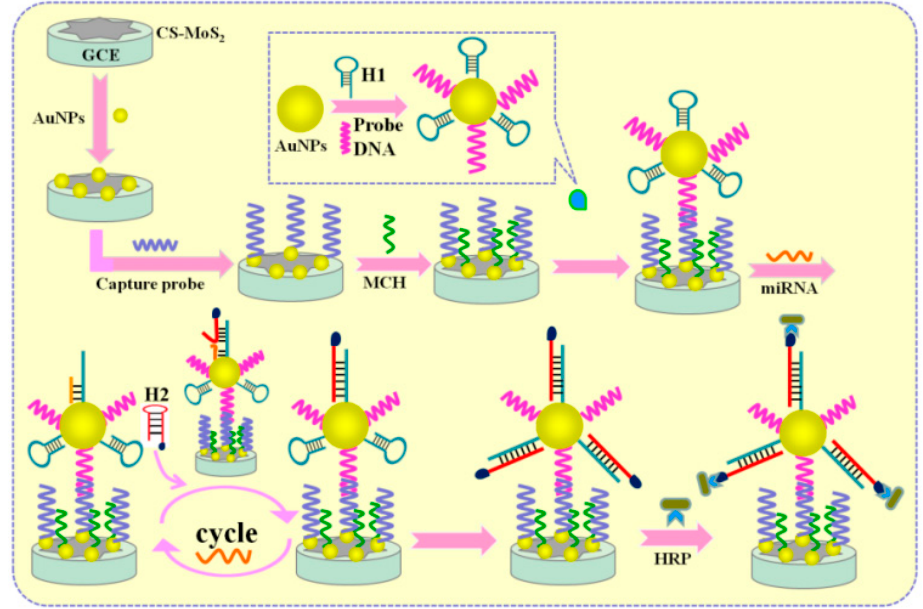
Figure 7. A sandwich-type electrochemical biosensing platform for microRNA-21 detection using carbon sphere-MoS2 and catalyzed hairpin assembly for signal amplification (reproduced with permission from the publisher) [109].